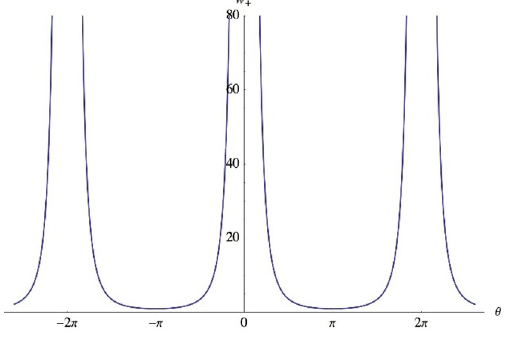
Figure 6 . The untwisted Wilson